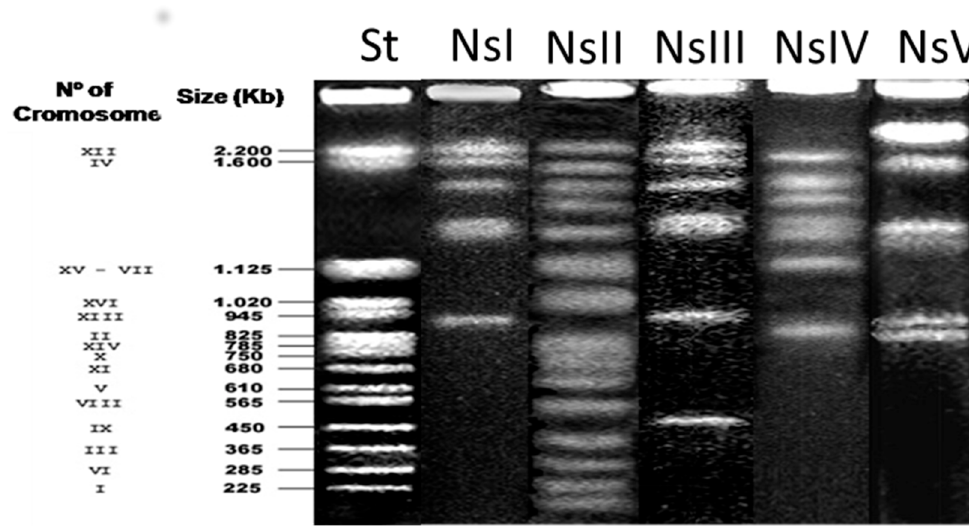
Figure 2. Karyotypes obtained by pulsed-field-gel electrophoresis (PFGE) of the non-Saccharoymyces veil-forming yeasts isolated in “Fino” Sherry wines. The species were identified as Zygosaccharomyces bailii (NsI), Torulaspora delbrueckii (NsII), Zygosaccharomyces rouxii (NsIII), Rhodotorula mucilaginosa (NsIV) and Rhodotorula minuta (NsV).